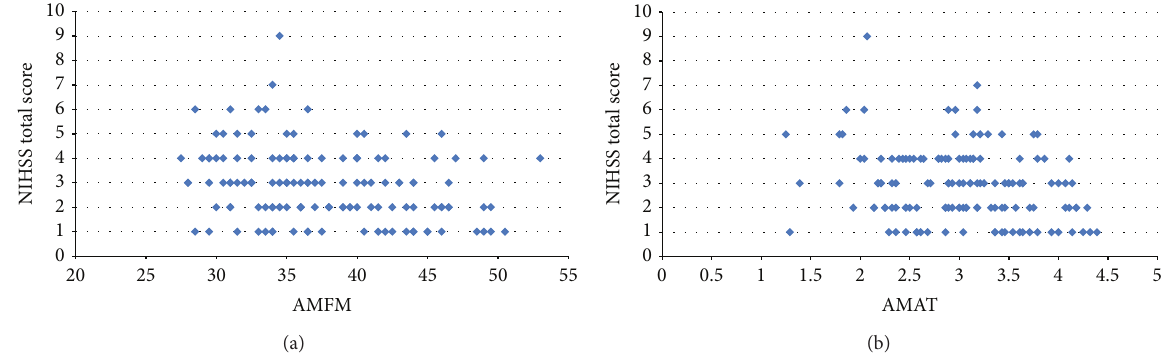
Figure 1: Bivariate plots comparing NIHSS scores with UE FM scores (a) and NIHSS scores with AMAT scores (b).